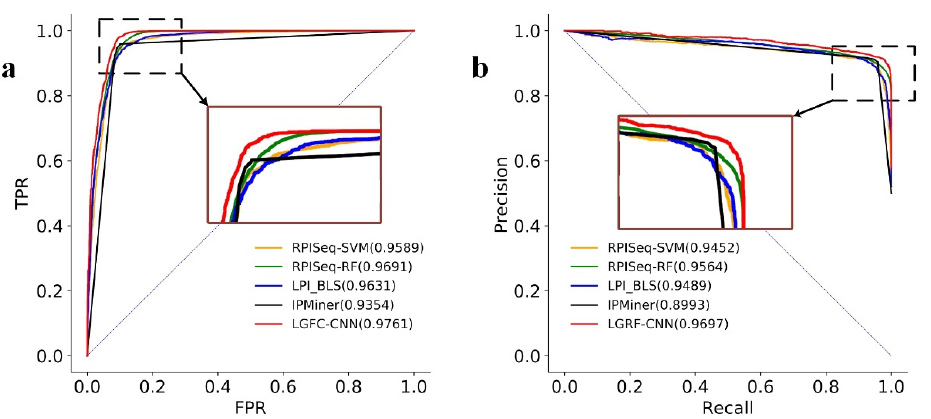
Figure 4. ( a ) The ROC curves and ( b ) the PRC curves of LGFC-CNN and other four methods on the RPI21850 dataset.